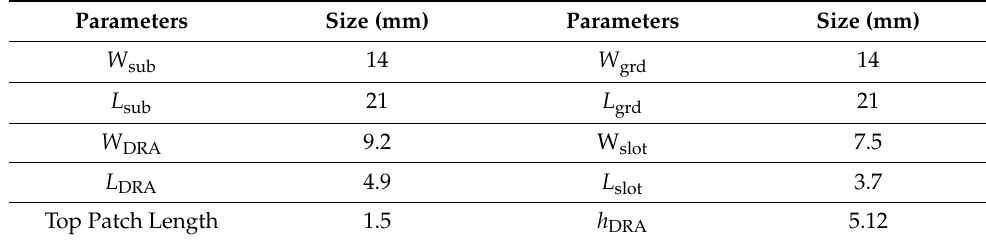
while, ( c ) shows the side view of the design. Table 1. Dimension table of the proposed design. Table 1. Dimension table of the proposed